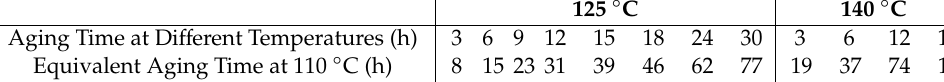
Table 1. Aging times at 125 ◦ C and 140 ◦ C (row 1) and the calculated equivalent aging times at 110 ◦ C (row 2) applying 80 kJ / mol (0.829 eV) activation